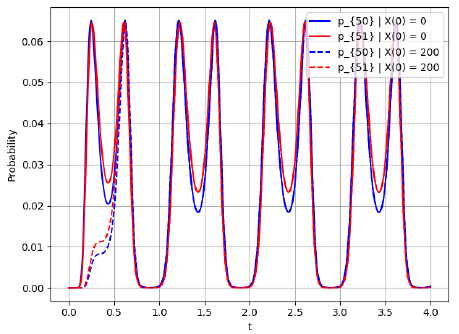
Figure 10. Probability p 50 ( t ) , p 51 ( t ) for t ∈ [ 0,4 ] ; this figure shows the rate of